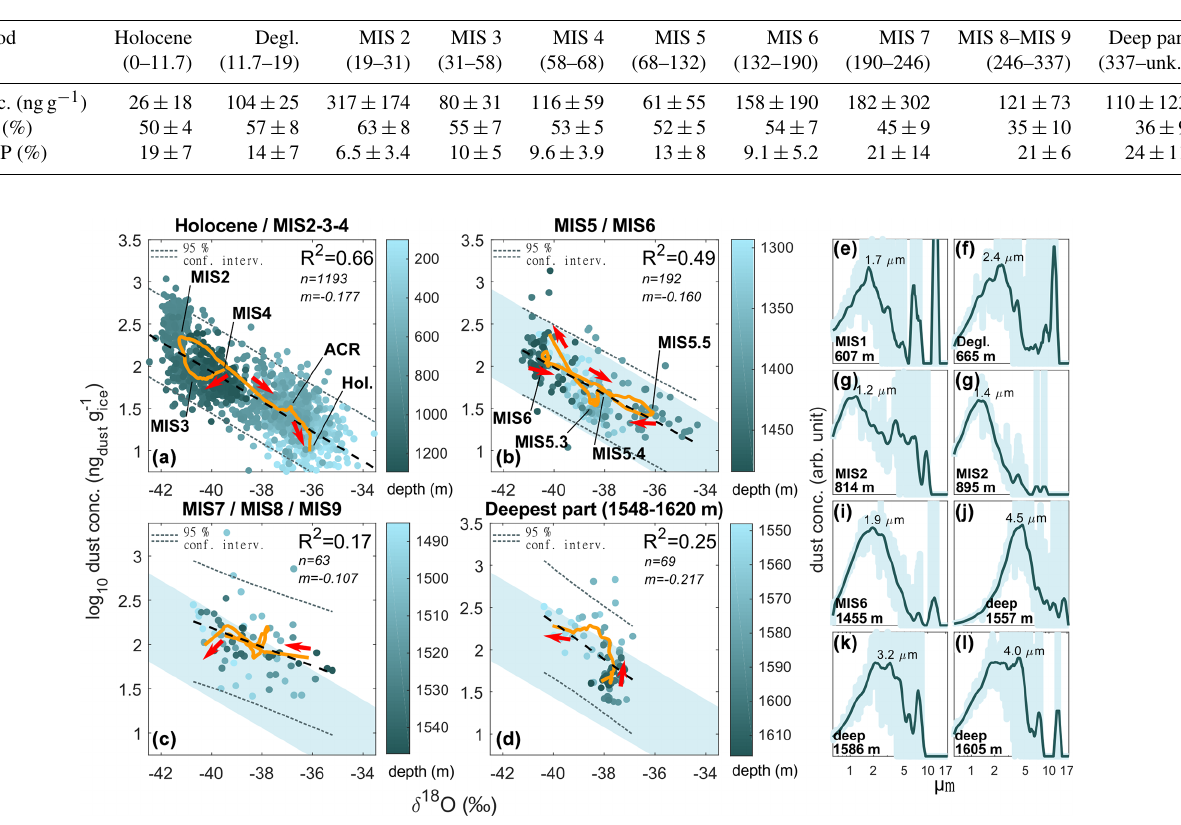
Figure 2. (a–d) Linear correlation between δ 18 O and dust concentration (logarithmic scale) in TALDICE. Dashed lines highlight the 95% confidence level interval of linear regression in each period; the blue band in panels (b–d) refers to the 95% confidence level interval of the linear regression calculated considering the last climatic cycle (a) . The orange curve is the trajectory showing the evolution with time of the δ 18 O–dust pair (arrows from deep to shallow). It was obtained applying a first-order (40% sample window) Savitzky–Golay filter to both variables. (e–l) Dust grain size distributions from